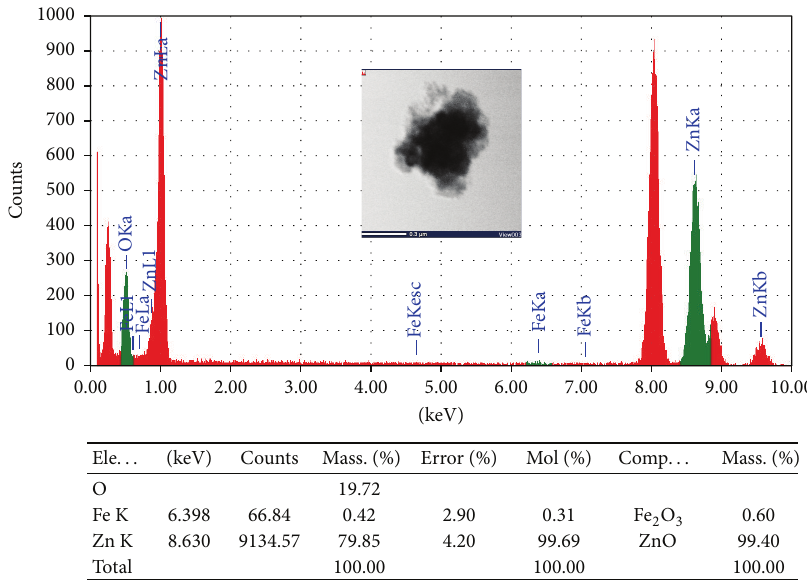
Figure 3: EDX spectra of sample ZnO-Zn-Fe ( 𝑥 Fe = 0.619 mass.%